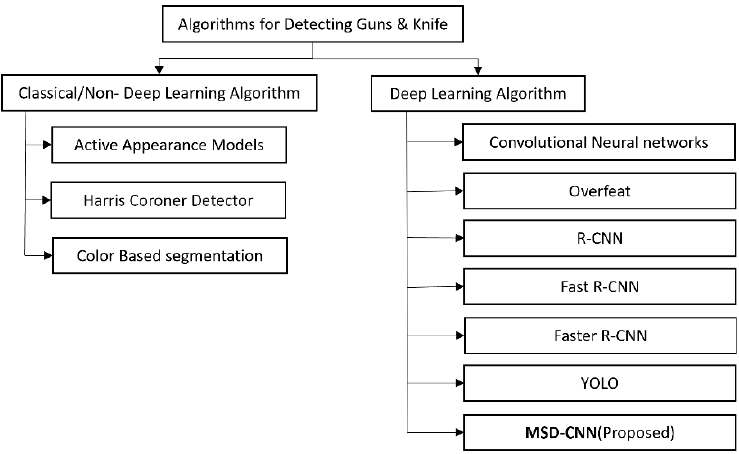
Figure 2. Taxonomy of algorithm for detecting guns and